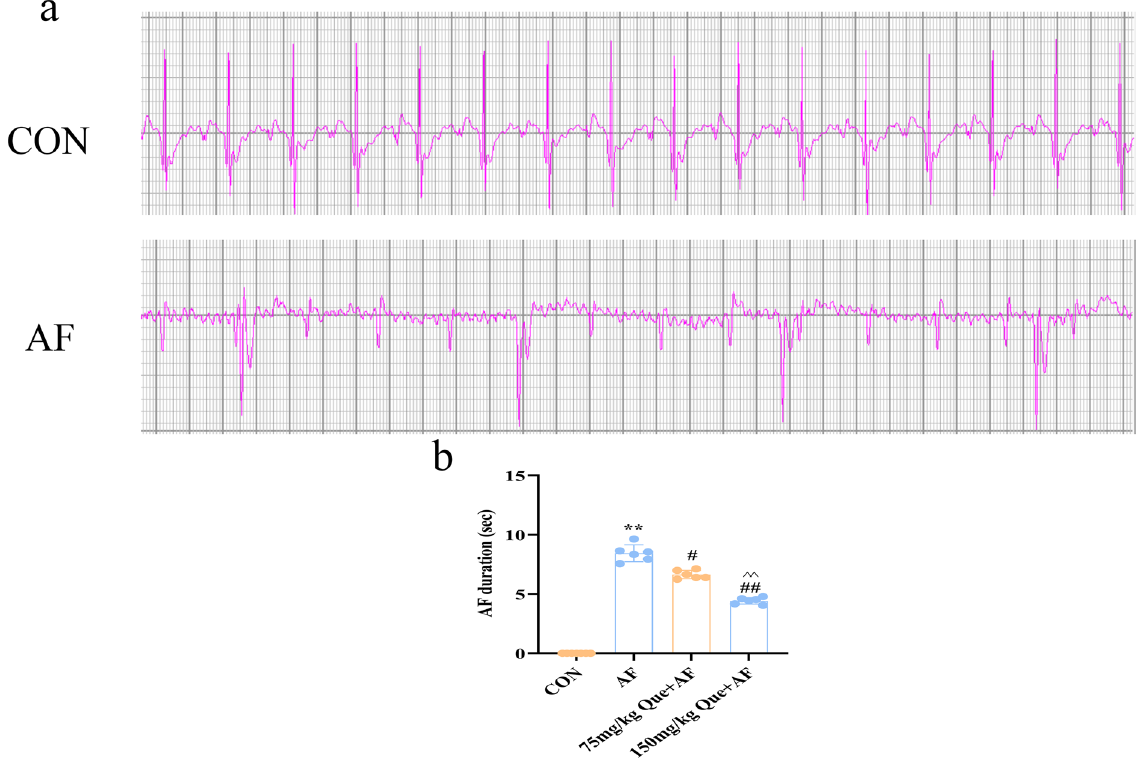
Figure 8. Que reduces the duration of paroxysmal AF (n = 6 for each group). ( a ) A rat model of AF was successfully established. ( b ) Duration of AF. **P < 0.01 VS CON; # P < 0.05 VS AF, ## P < 0.01 VS AF; ^^ P < 0.01 VS 75 mg/kg Que +